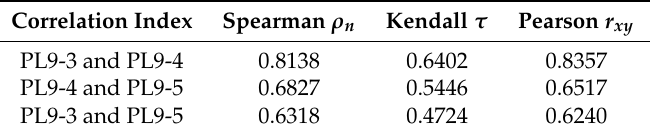
Table 4. Correlations between each pair of random variables.